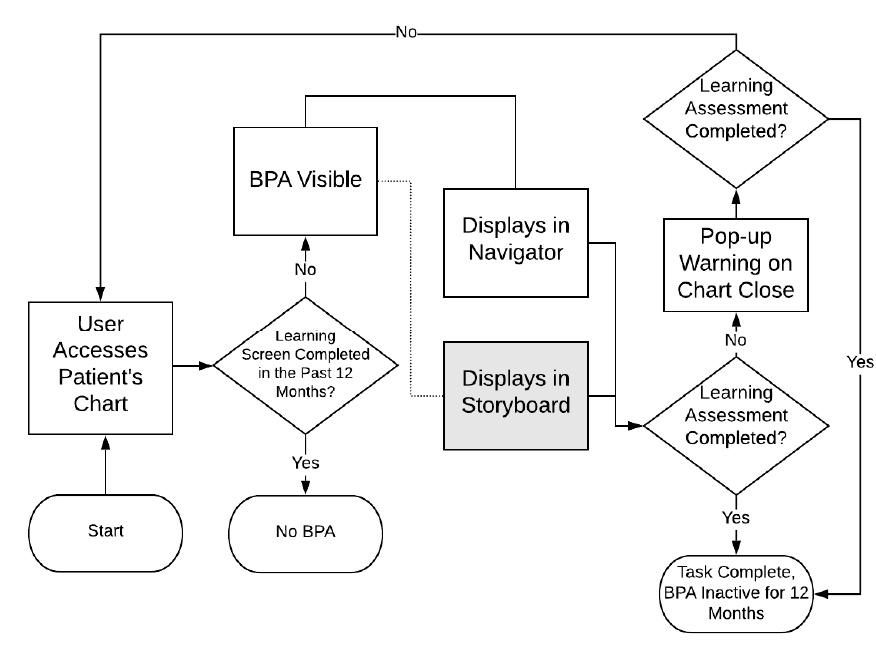
Figure 2. Learning Screen BestPractice Advisory (BPA) Functionality.